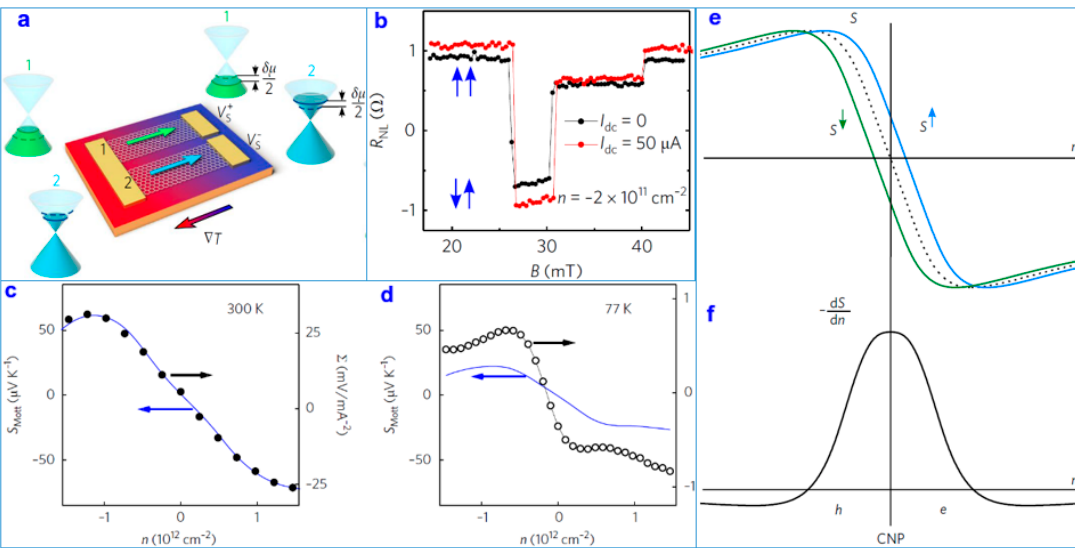
Figure 14. ( a ) Schematic of the test device. ( b ) Nonlocal spin resistance R NL versus magnetic field B along the magnetization of the electrodes for I dc = 0 (black line) and I dc = 50 µ A (red line). Blue arrows show the relative direction of the ferromagnetic magnetization. ( c ) Comparison between the Mott Seebeck coefficient S Mott versus carrier density n (blue line and left axis) obtained from the graphene square resistance R at room temperature and the quadratic fitting coefficient Σ versus n . Modelling and roles of the Seebeck coefficient and the spin accumulation in ( e , f ), with qualitative representation of S ( a ) and its derivative dS / dn ( b ) about the CNP [124]. Copyright 2018, Springer Nature.